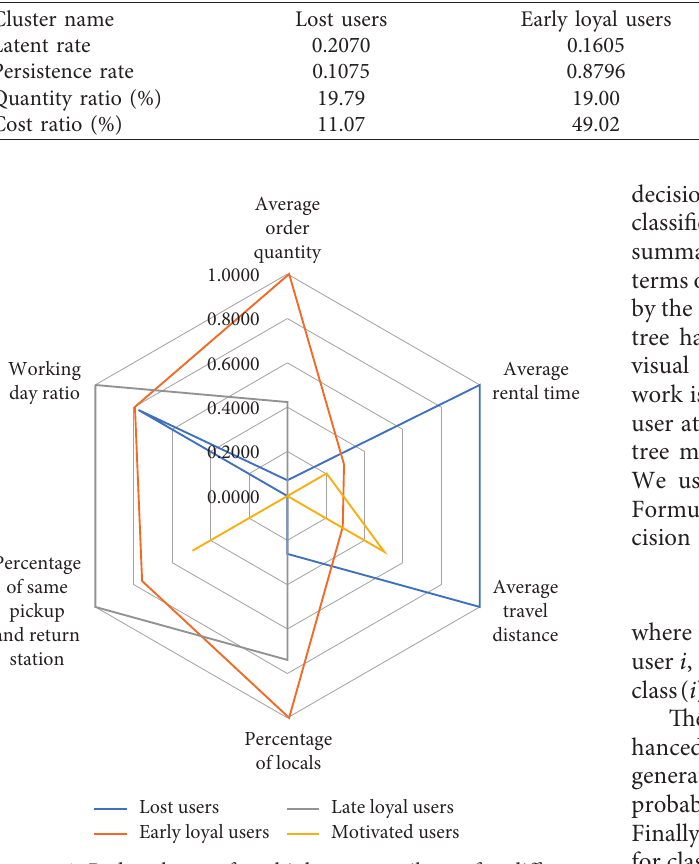
Figure 6: Radar charts of multiple user attributes for different users.